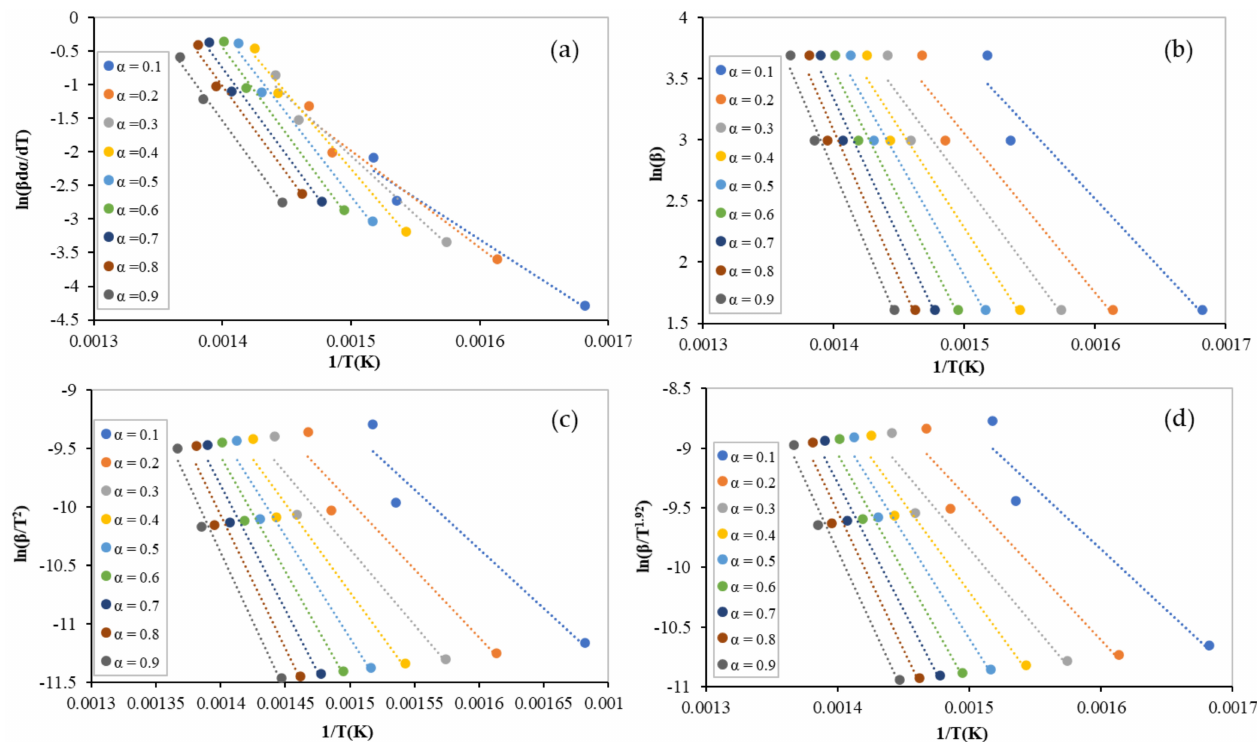
Figure 3. Linear regression lines of binary equi-mass PP and PS mixtures at different conversions by: ( a ) Freidman; ( b ) FWO; ( c ) KAS; and ( d ) Starink.